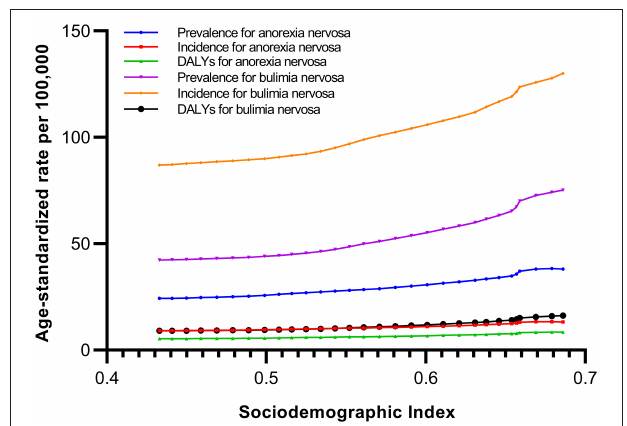
FIGURE 3 | Age-standardized prevalence, incidence, and DALY rates of anorexia nervosa and bulimia nervosa in China by sociodemographic index,